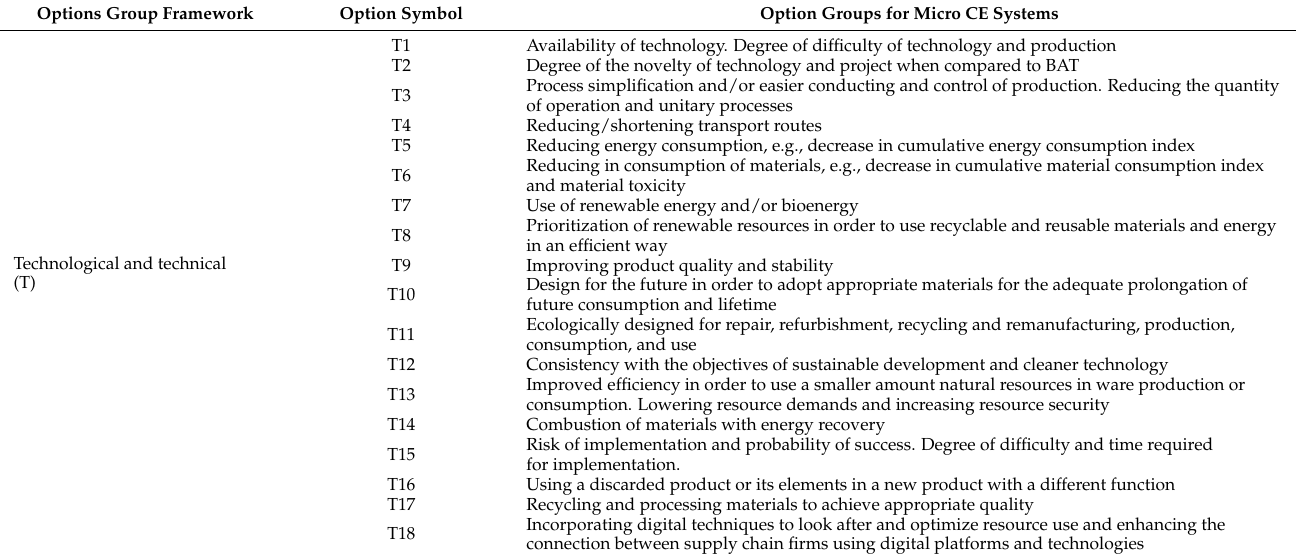
Table 3. Options for the assessment of CE micro-level